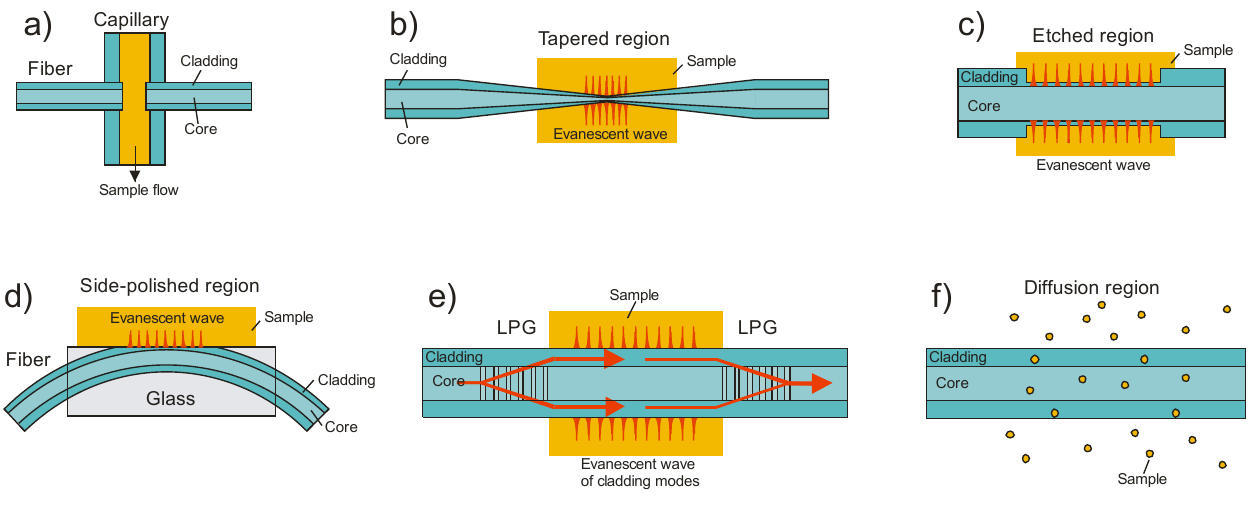
Figure 3. Different types of sensor elements used in fiber-cavity ring-down spectroscopy. (a) A gap in the fiber allows for direct absorption of all propagated light through the sample. (b) In a tapered fiber the core mode is converted into a cladding mode and the evanescent field extends outside the fiber. (c) By etching the cladding the evanescent field can also be extended into the sample. (d) In a field access block the cladding thickness is reduced by side-polishing the fiber and the evanescent field then reaches the surrounding material. (e) A pair of identical long-period gratings (LPGs) couples light from the core mode into a single cladding mode and then back into the core. Between the two LPGs